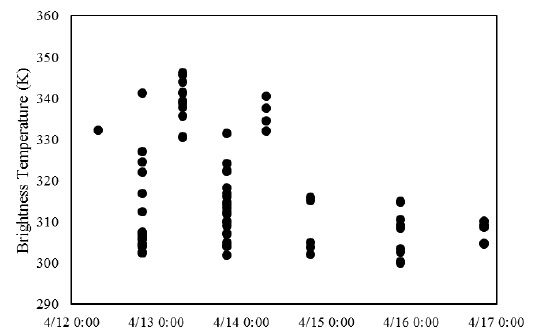
Figure 7 . Fire pixels in terms of brightness temperature (K) in west Chitwan, Nepal by VIIRS.